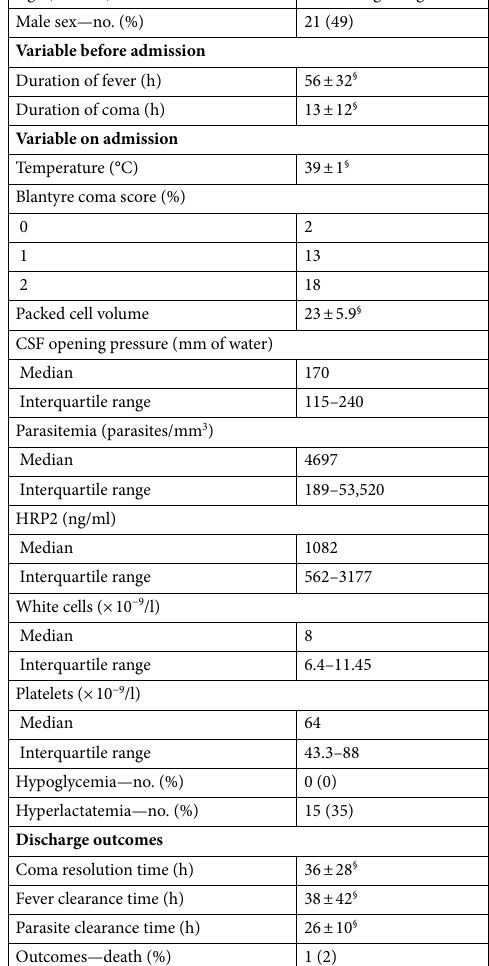
Table 2. Clinical data in CM patients. Data with ‘ § ’ presented as mean ± SD. HRP2 histidine-rich protein